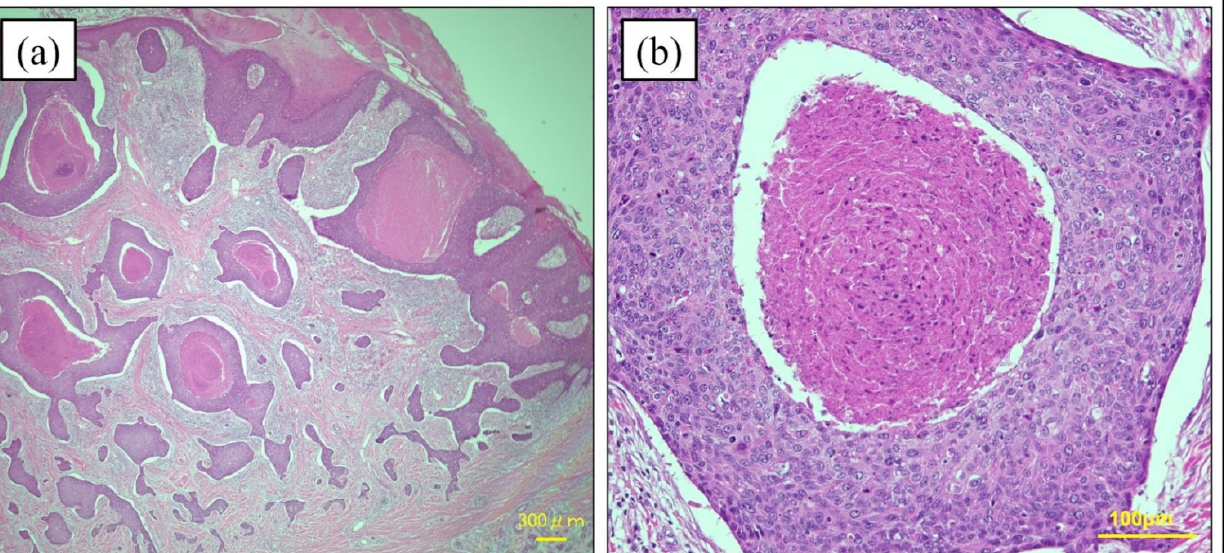
Figure 3. Histopathological findings of ductal formation. ( a ) Clear cell changes in the tumor are observed. ( b ) Mature ductal formation and atypical cell proliferation are found. (Hematoxylin and eosin stain; ( a ) original magnification ×200, ( b ) original magnification ×200). 4.4. Immunohistochemistry Immunohistochemical analysis is a useful tool for diagnosing PC. Several immuno- histochemical markers have been used to differentiate benign poroid tumors from malig- nant tumors. Immunohistochemical staining for carcinoembryonic antigen (CEA) and ep- ithelial membrane antigen (EMA) has been frequently used to identify ductal structures.